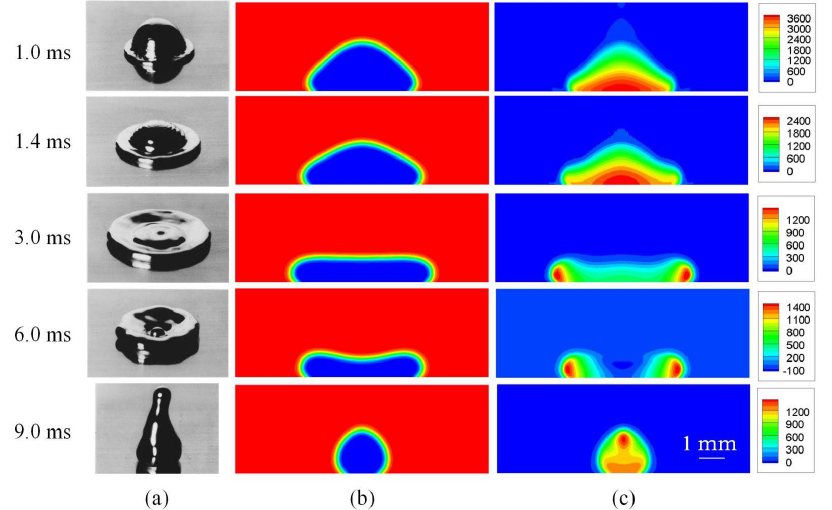
Figure 8. Validation of the model. The experimental photographs are taken from Aziz et al. Reprinted with permission from Ref. [29] Copyright Phys. Rev. E 1998, where ( a ) is of experimental results, ( b ) is of drop profile and ( c ) is of pressure distribution, measured in Pa. Figure 9 compares the spread factor evolution, displaying reasonable agreement dur- ing both spreading and retraction phases. The spread factor is defined as the ratio of the changing drop diameter in the x direction to the initial drop diameter.